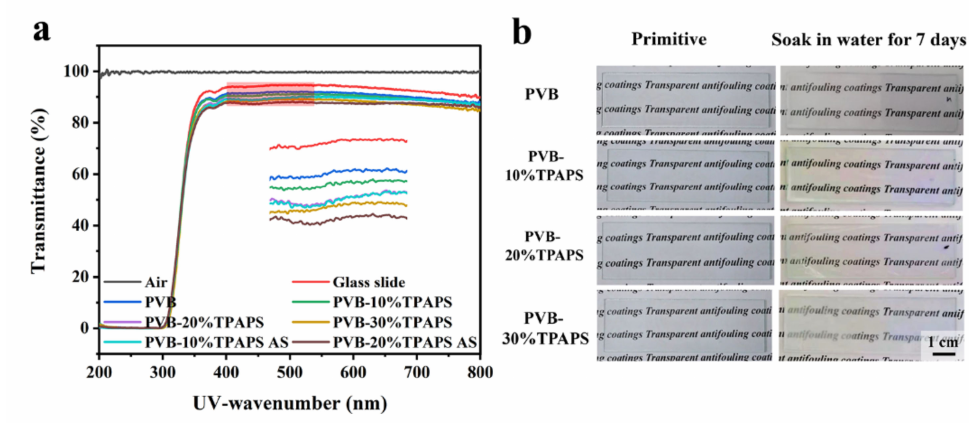
Figure 6. Optical transmittances of the PVB-X% TPAPS coatings. ( a ) Transmission curve of visible light (400–800 nm) compared with the glass slide and ( b ) photographs of coating before and after soaked in water for 7